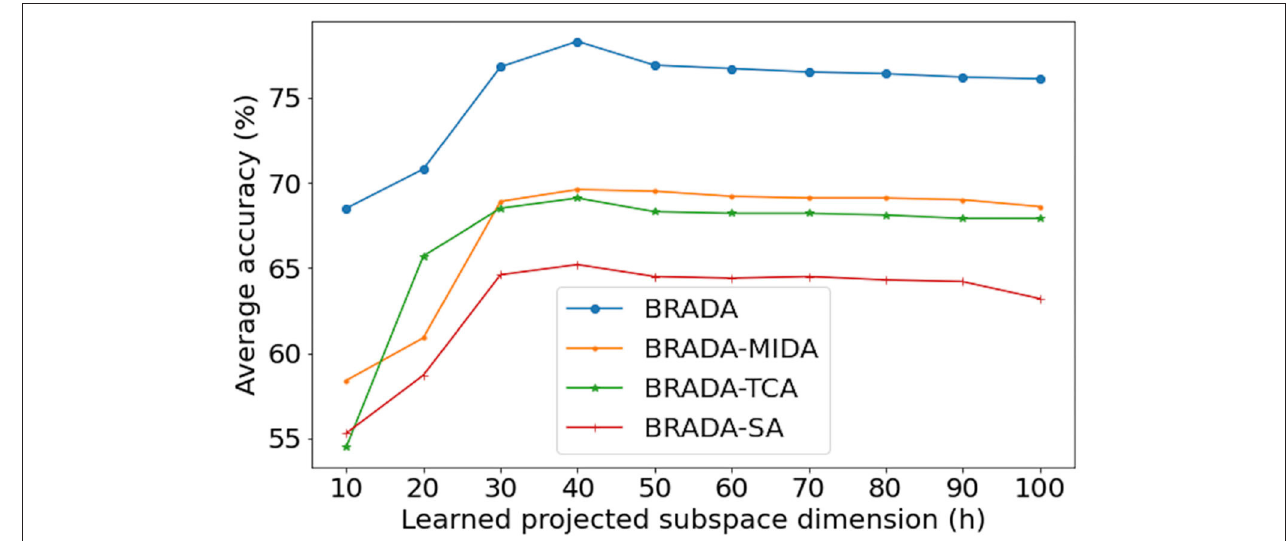
FIGURE 7 | Average valence performance accuracy on MAHNOB-HCI using varying projected